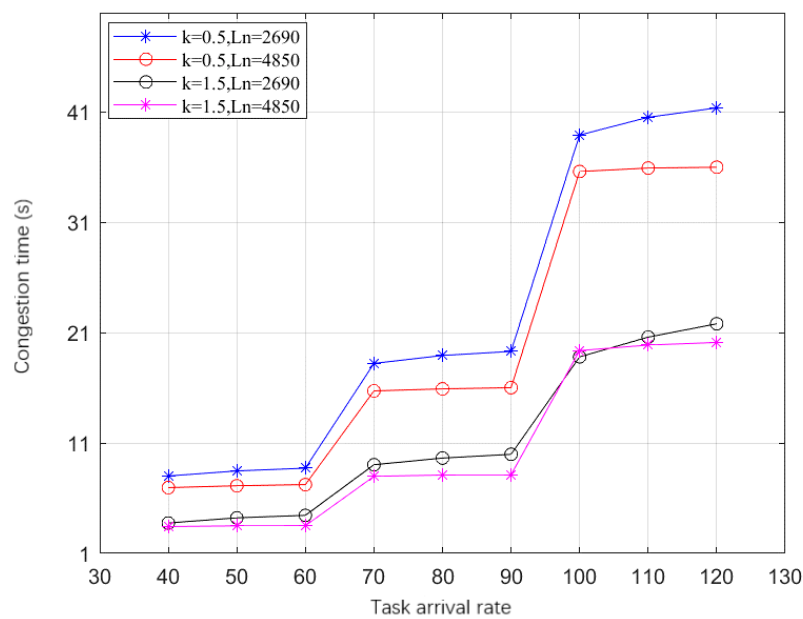
Figure 11. The variation of the congestion time with the task arrival rate.